Question: Does the plotted quantity increase or decrease?
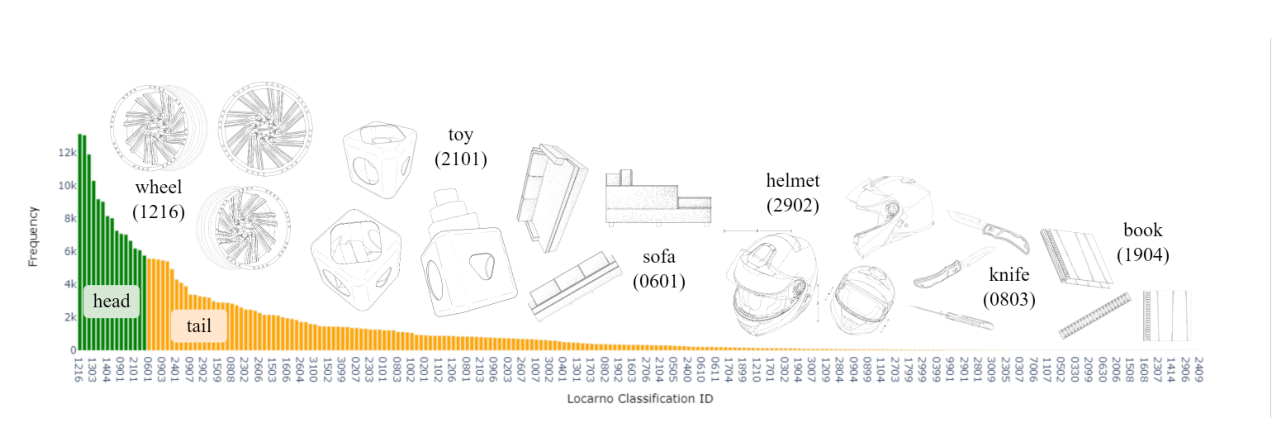
Answer: increasing